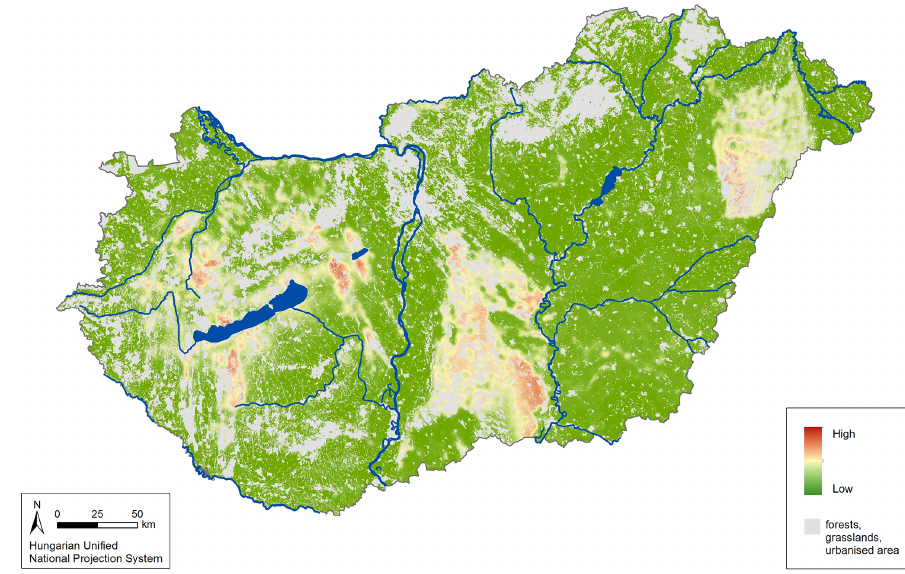
Figure 8. Wind erosion susceptibility map of the Hungarian